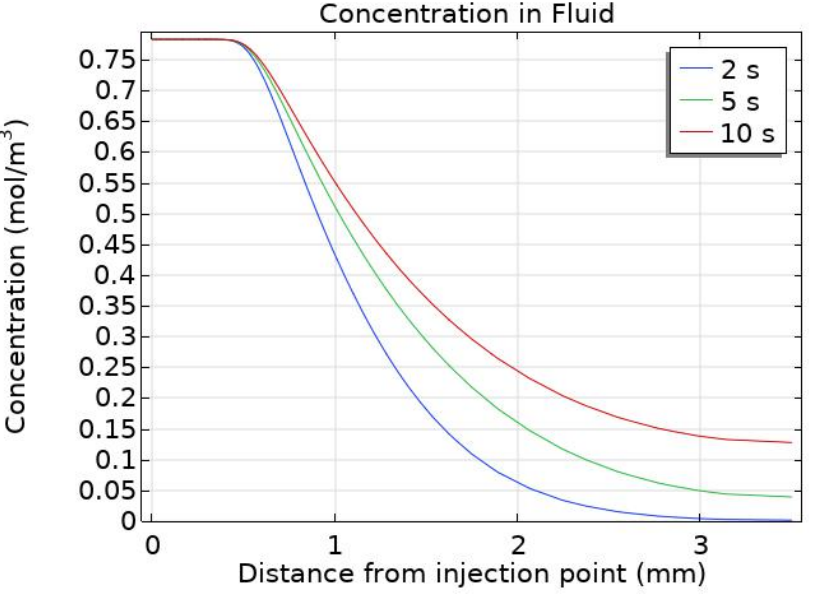
Figure 5. Particle concentration within the fluid during injection at 2 s, 5 s, and 10 s, along the dis- tance from the point of injection. from the point of